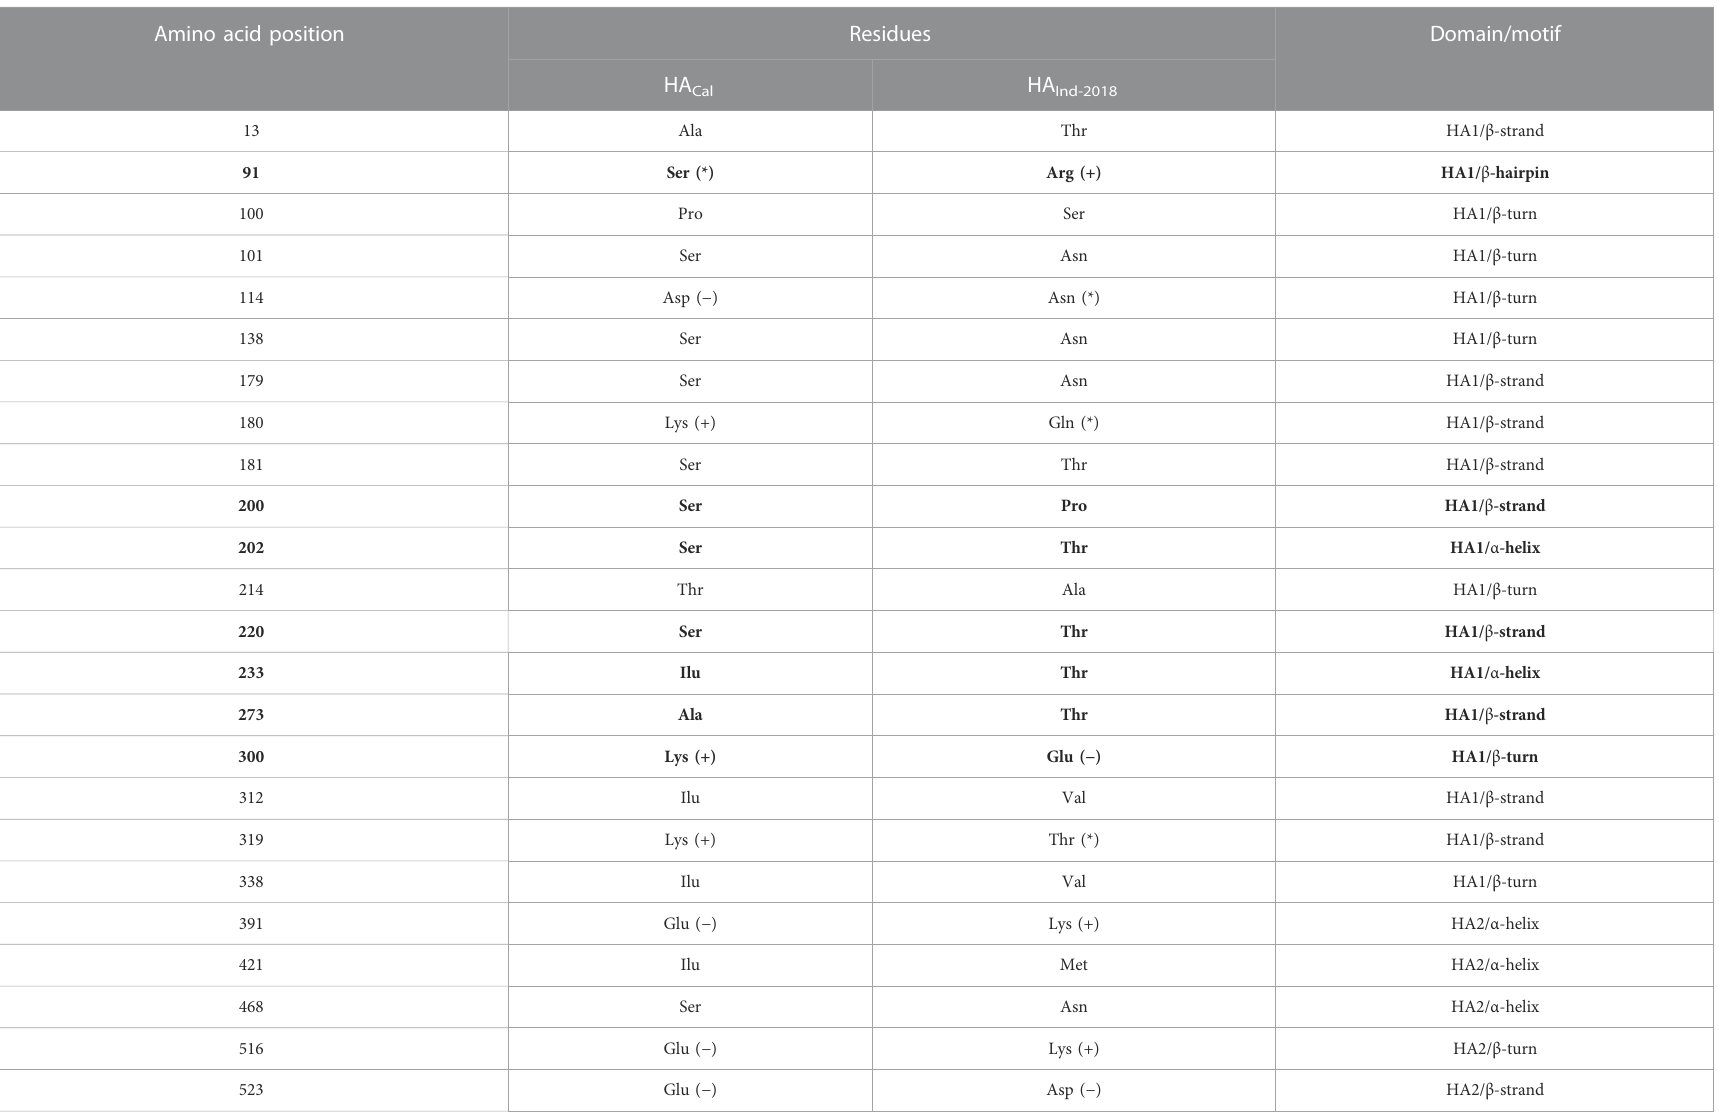
TABLE 7 List of mutated residues and their locations in both HA Cal and HA Ind protein structures. The RBD residues are in bold, and the mutated residues (from charged to uncharged and vice versa ) are indicated by